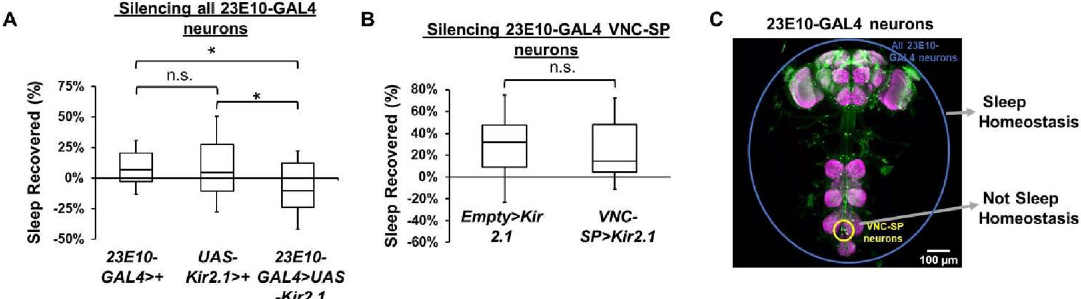
Fig 5. Multiple sleep-regulating regions in 23E10-GAL4 with functional specificity? ( A ) Box plots of total sleep recovered in % during the first 24 h following 12 h of sleep deprivation at night for 23E10-GAL4/+ and UAS-Kir2 . 1/+ parental controls and 23E10-GAL4 > UAS-Kir2 . 1 female flies. A one-way ANOVA followed by Tukey’s multiple comparisons demonstrate that both parental controls have a bigger homeostatic sleep rebound than 23E10-GAL4 > UAS-Kir2 . 1 female flies. � P < 0.05, n.s. = not significant, n = 47–62 flies per genotype. ( B ) Box plots of total sleep recovered in % during the first 24 h following 12 h of sleep deprivation at night for Empty- AD; 23E10-DBD > UAS-Kir2 . 1 and VT013602-AD; 23E10-DBD > UAS-Kir2 . 1 female flies. A two-tailed unpaired t test revealed that there is no difference in homeostatic sleep rebound, n.s. = not significant, n = 24–29 flies per genotype. ( C ) Representative confocal stacks of a female 23E10-GAL4 > UAS-GFP fly highlighting different 23E10-GAL4 expressing neurons and their different roles in sleep modulation. The raw data underlying parts (A) and (B) can be found in S1 Data. VNC-SP, VNC sleep-promoting.